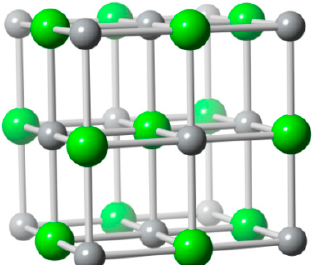
Figure 8. The AgCl structure, a FCC unit cell with two ions (ICSD no. 56538) ( Ag and Cl − are gray and green atoms respectively) per lattice point.